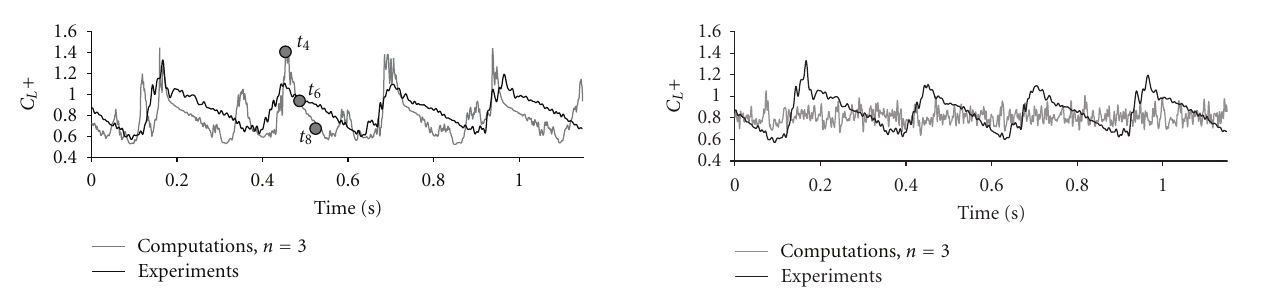
Figure 13: Comparisons of the measured and the predicted suction side lift coe ffi cients obtained using the Merkle cavitation model with n = 3. σ = 1, Re = 750,000, V ∞ = 5 m/s, and α = 6 ◦ .